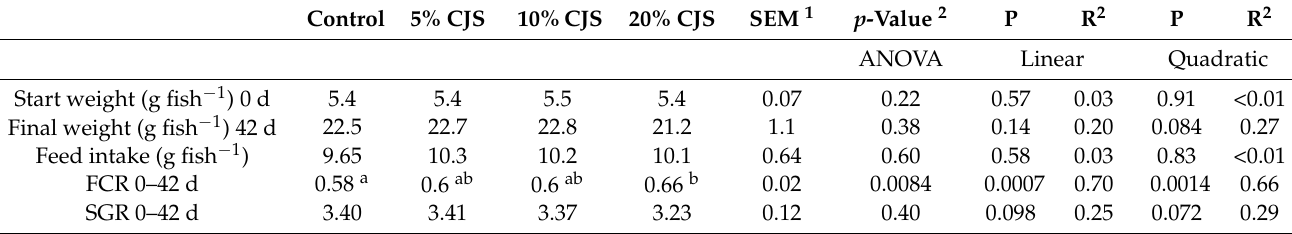
Table 3. Weights, feed conversion ratio (FCR), and specific growth rate (SGR) for Atlantic salmon ( Salmo salar ) fed increasing dietary levels of Cyberlindnera jadinii (CJS) in the retention